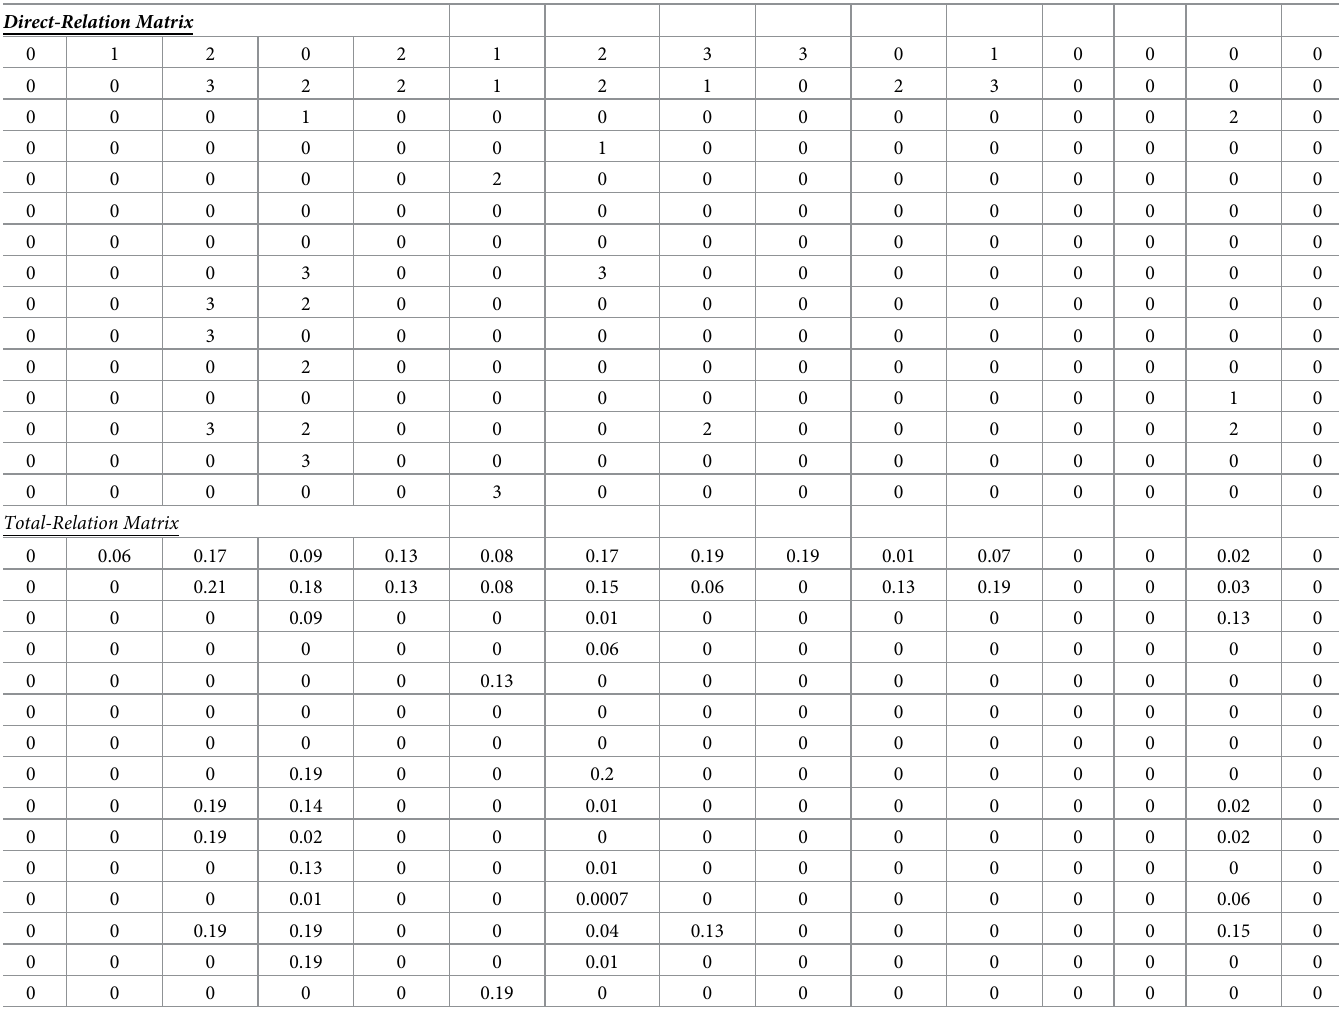
Table 2. Direct-relation matrix and total-relation